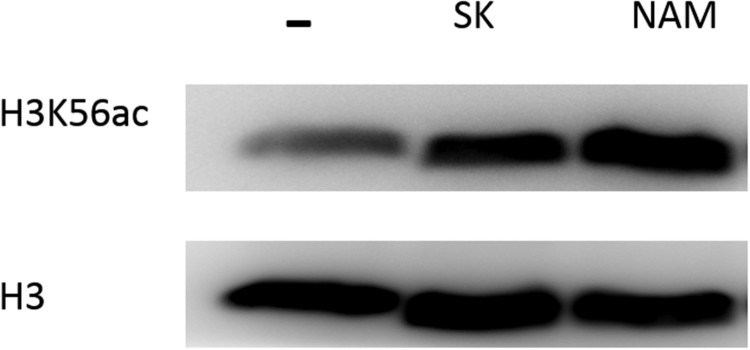
Immunoblot analysis of H3K56ac from whole-cell extracts of C. albicans SC5314 untreated, SK-treated (8 μg/ml), and NAM-treated (6.4 mg/ml). Protein was separated with SDS gels, and then probed with rabbit anti-H3K56ac or rabbit anti-H3 to detect the levels of H3K56ac and H3 protein. NAM, nicotinamide; SK, Shikonin.